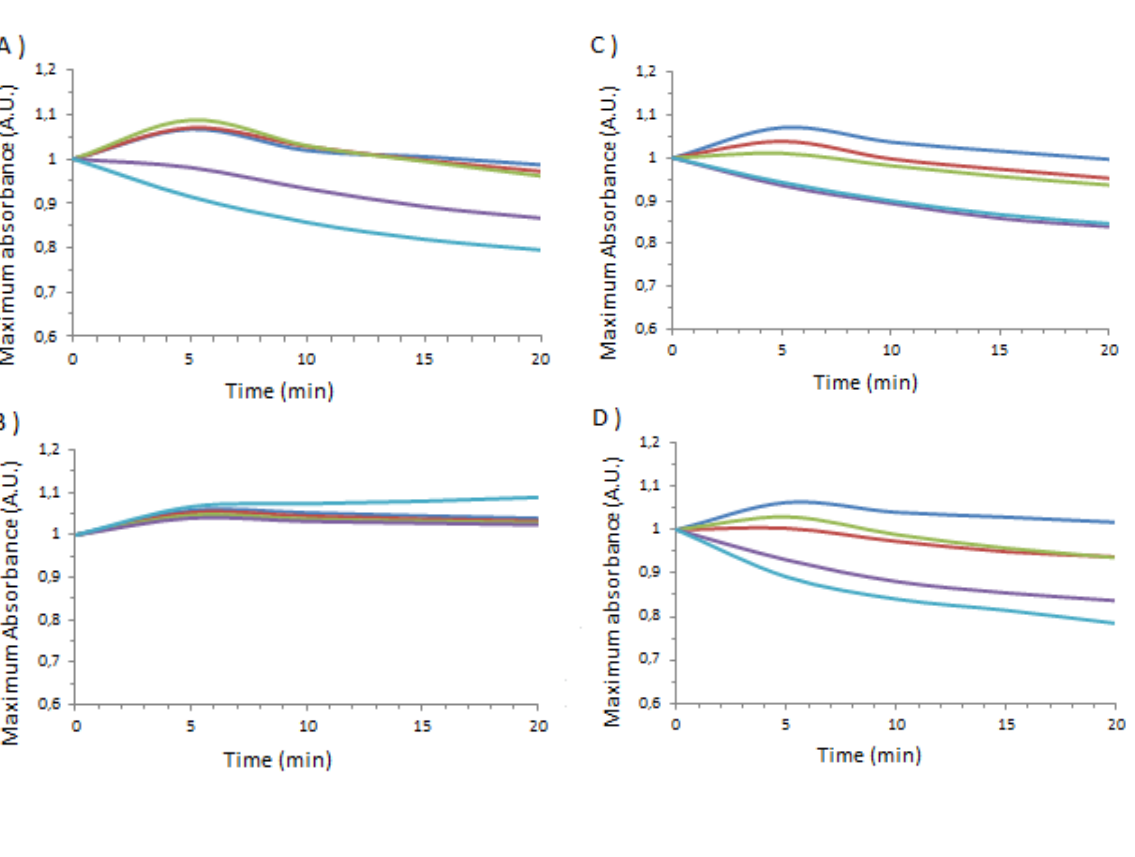
Figure 7. Maximum absorbance, normalized to 1 at time zero of calix[n]arene capped silver nanoparticles mixed with different albumin species as a function of time and temperature (thick blue: 20 °C, red: 30 °C, green: 40 °C, purple: 50 °C and sky blue: 60 °C). On the left, 1 _Ag_NP mixed with BSA ( A ), HSA ( B ), PSA ( C ), and SSA ( D ); on the right 2 _Ag_NP mixed with BSA ( E ), HSA ( F ), PSA ( G ) and SSA ( H